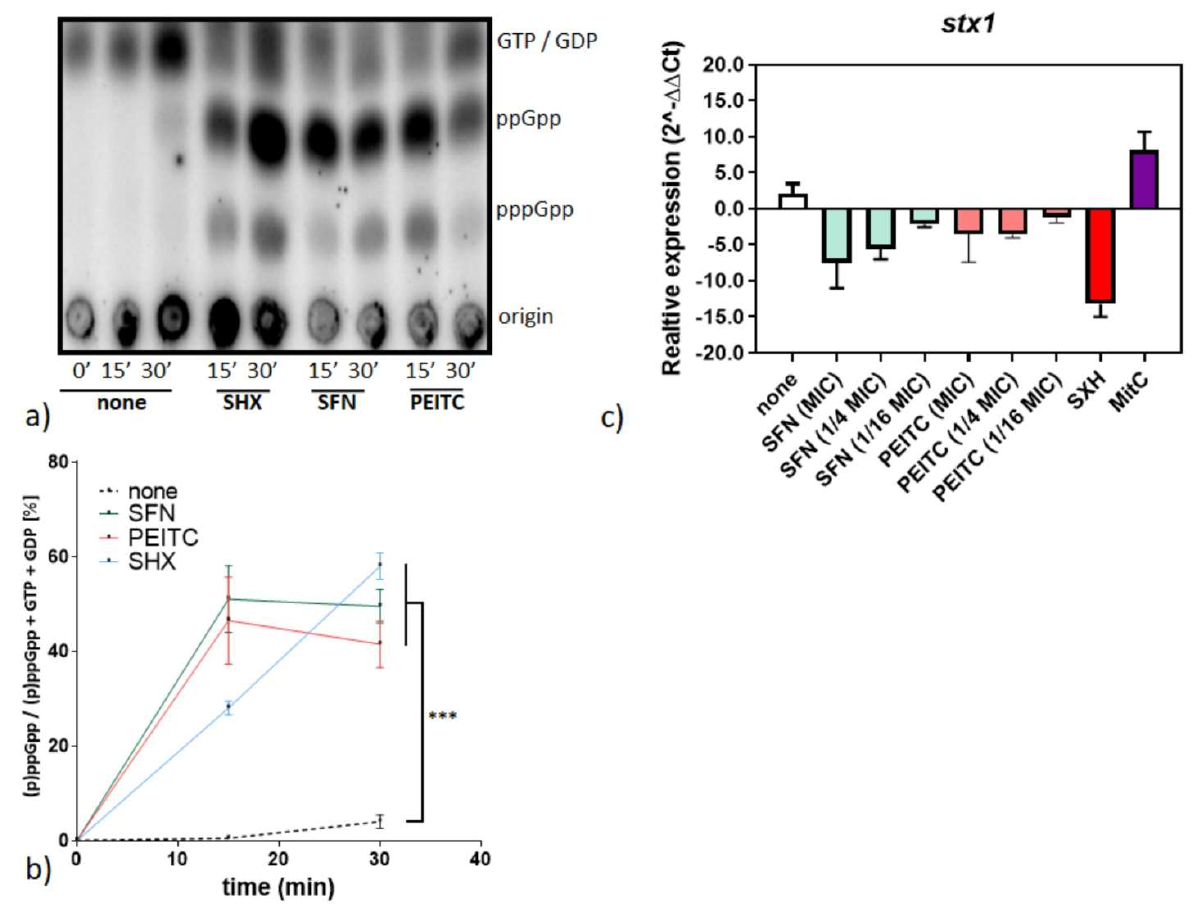
Figure 3. SFN and PEITC impair expression of the Shiga toxin genes and induce stringent response in S. dysenterae . ( a ) Synthesis of the stringent response alarmones, ppGpp and pppGpp, was assessed by culturing bacteria with the addition of [ 32 P]orthophosphoric acid (150 µCi/mL) followed by cell lysis and nucleotide separation by thin-layer chromatography. ITC or SHX were added at time zero. Samples were withdrawn at 15 and 30 min after the compound addition. The positions of ppGpp and pppGpp are indicated at the right side of the panel. ( b ) Relative cellular level of (p)ppGpp was assessed densitometricaly, where treated samples were compared to the nontreated negative control (at the 30 min endpoint) using Student’s t -test. Statistical significance is marked with asterisks: *** p < 0.001; ( c ) Relative expression of stx 1 in S. dysenteriae SZ2855/97 Japan was determined by qRT-PCR and is presented using 2 −ΔΔCT quantification normalized to the recA gene expression level.